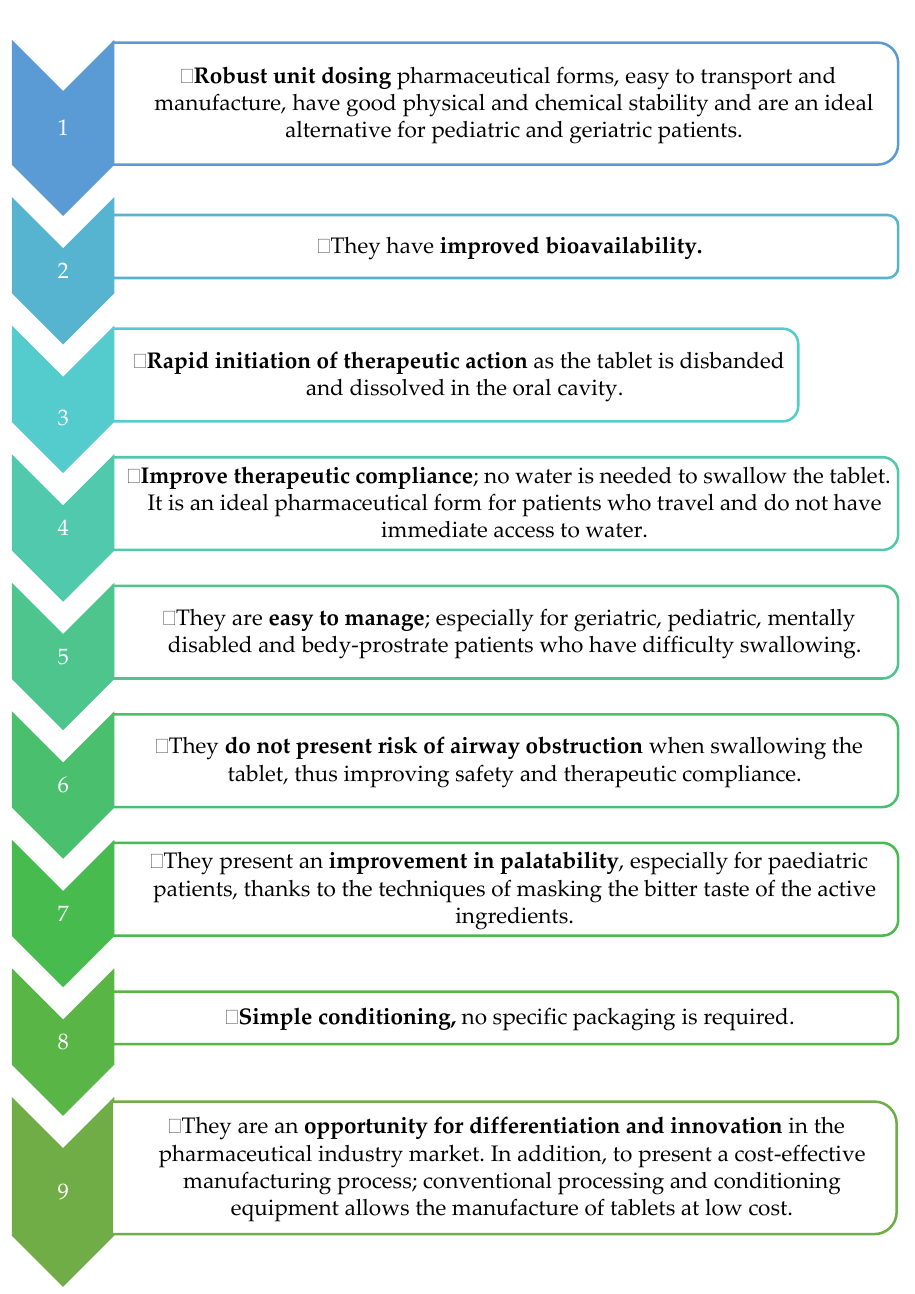
Figure 1. Characteristics and advantages of ODT tablets. Figure 2 specifies the most noteworthy drawbacks of ODT tablets [54].